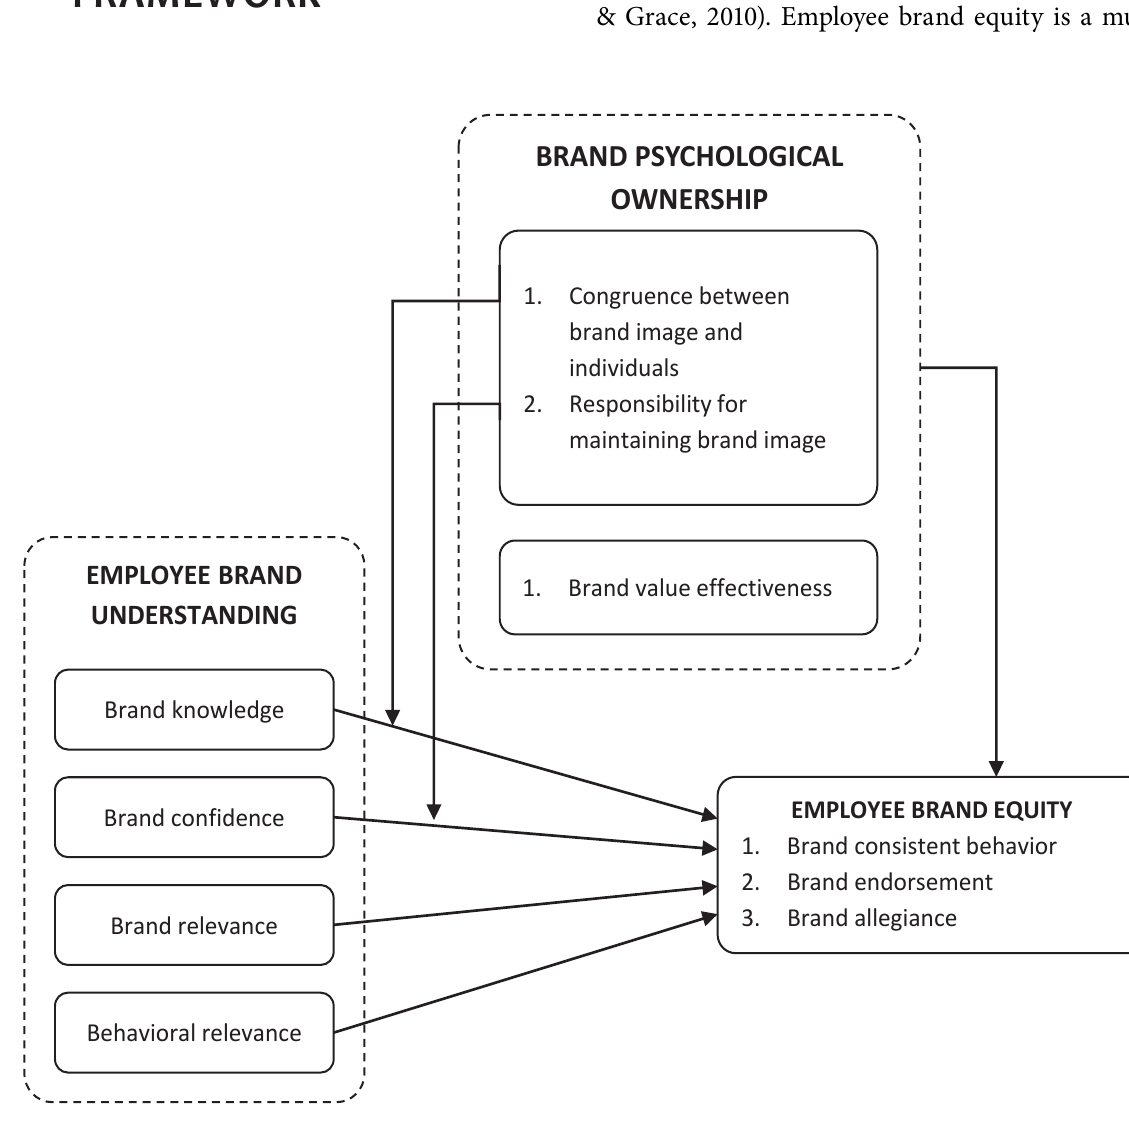
Figure 1. Research